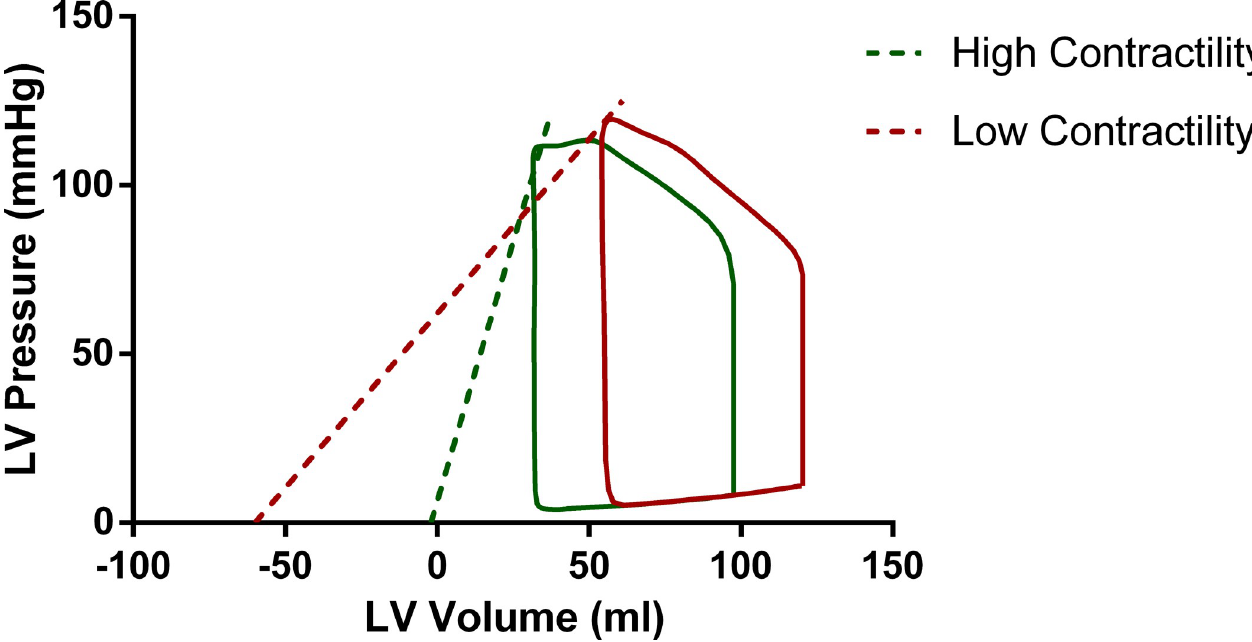
Fig 1. Intraventricular pressure-volume loops for two scenarios of high ( E es = 3 mmHg/mL, V d = − 2 mL—green curve) and low ( E es = 1 mmHg/mL, V d = − 60 mL—red curve) LV contractility with a maintained stroke volume. Note that for the low E es scenario an increase in preload was needed in order to restore stroke volume. The dashed lines represent the respective linear